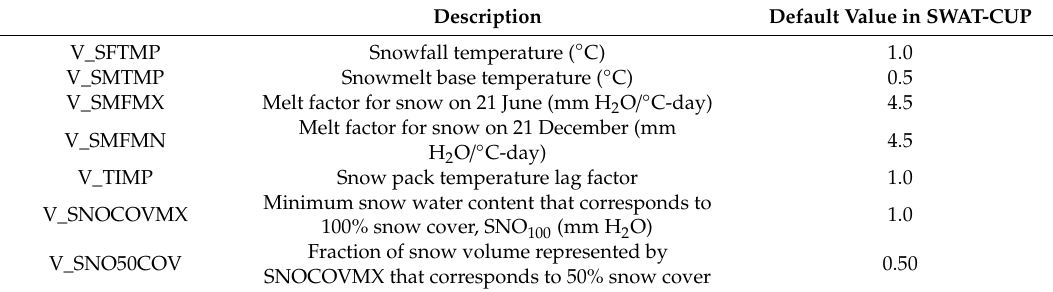
Table 2. Description of snow parameters and their default values in